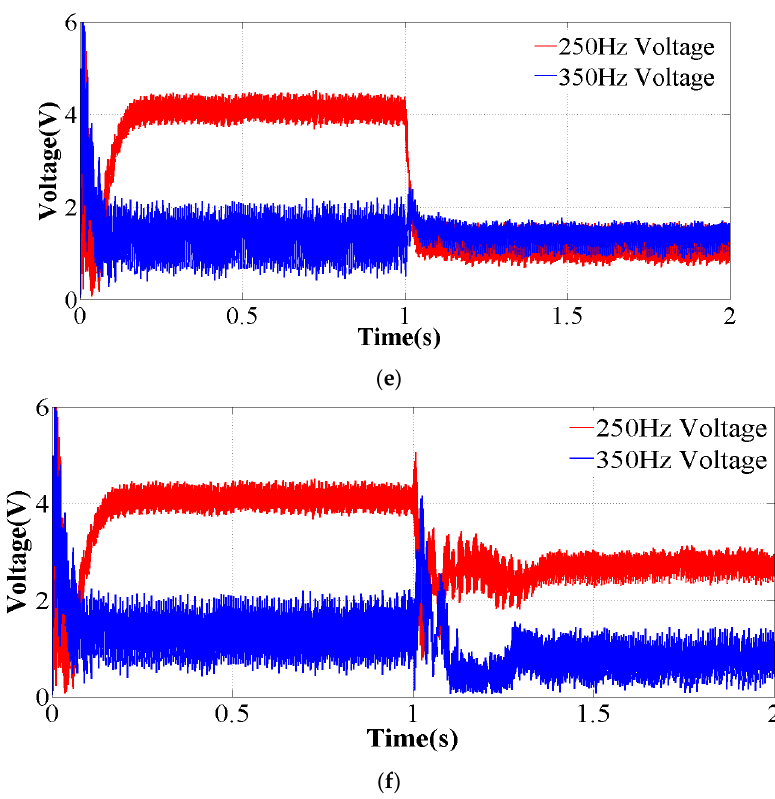
Figure 9. The voltage analysis when the load is non-linear. ( a ) The FFT of the line voltage without compensation; ( b ) The FFT of the line voltage with 250 Hz, 350 Hz harmonic voltage mitigation with the conventional algorithm; ( c ) The FFT of the line voltage with 250 Hz, 350 Hz harmonic voltage mitigation with the proposed algorithm; ( d ) The magnitude of 250 Hz, 350 Hz harmonic voltage without compensation; ( e ) The magnitude of 250 Hz, 350 Hz harmonic voltage with the conventional mitigation algorithm; ( f ) The magnitude of 250 Hz, 350 Hz harmonic voltage with the proposed mitigation algorithm.